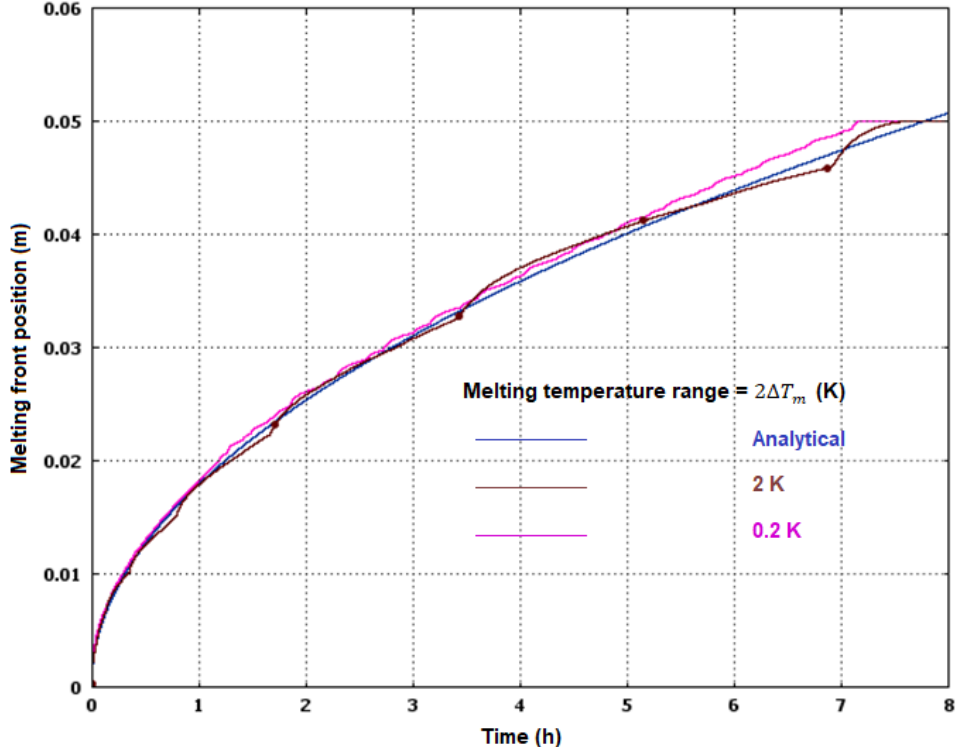
Figure 9. The effect of the melting range on the results’ accuracy.